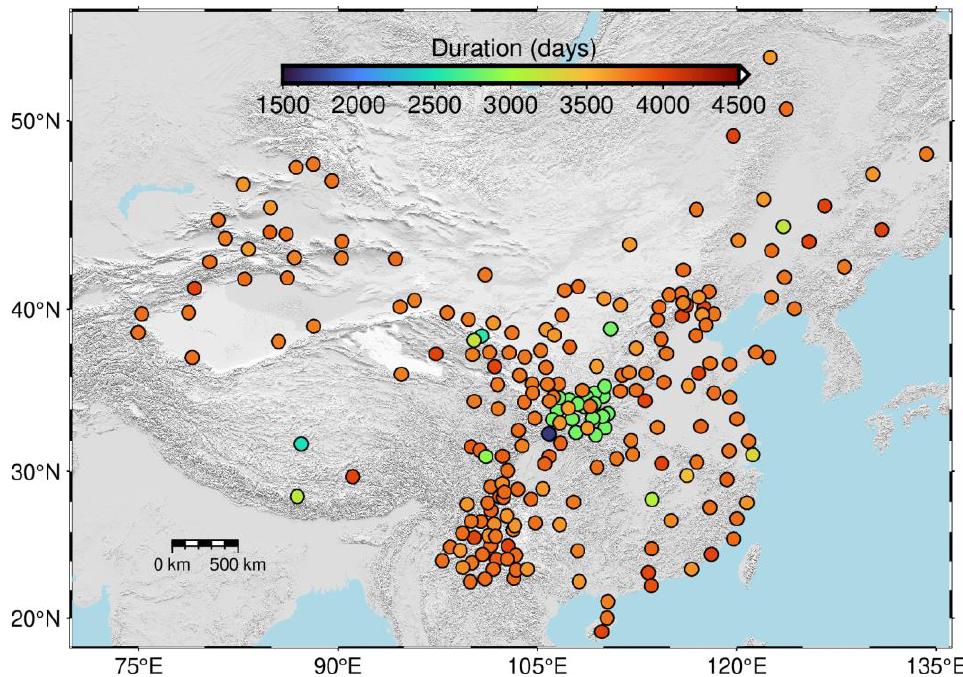
Figure 3. Spatial locations and time spans of selected 226 continuous GPS stations from CMONOC. The color declares the observation days of each station.